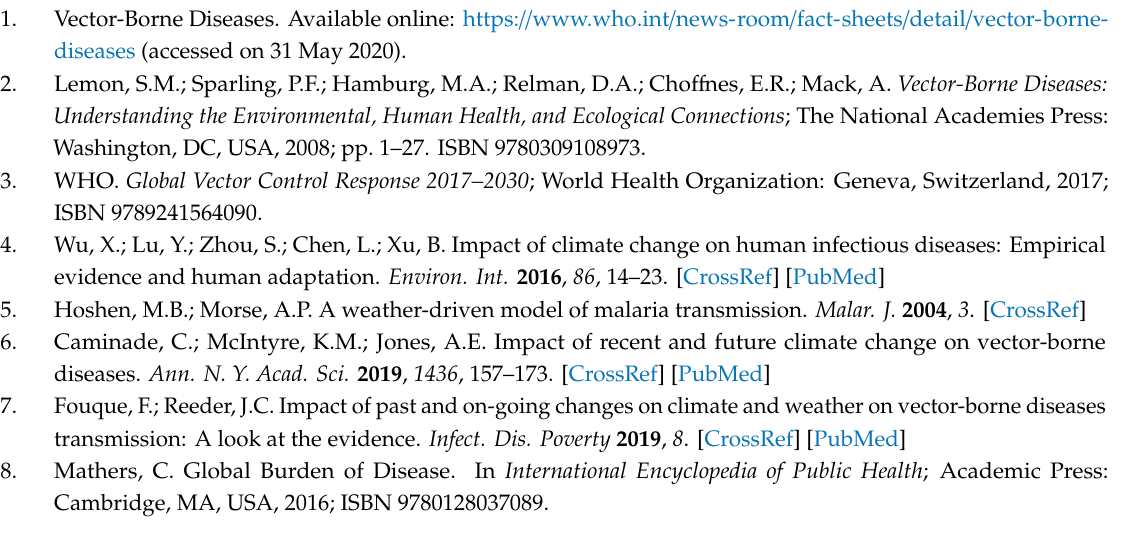
Table S1: Relevant Intervention(s), Study Design, Relevant Key Finding(s) and / or Conclusion of Each Reviewed Article Referenced ( n =